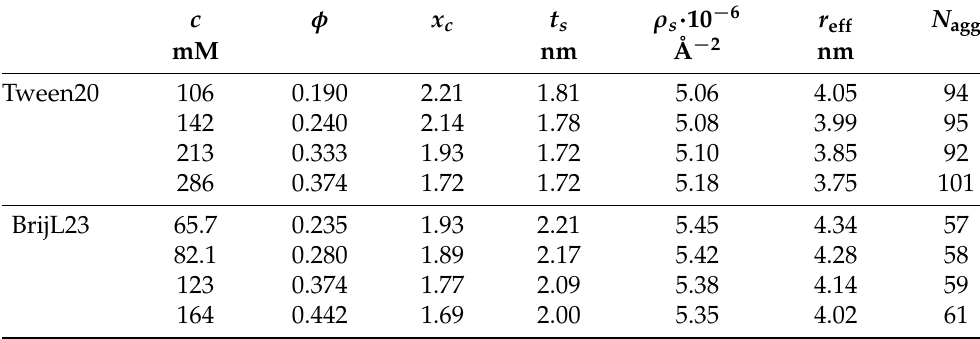
Table 1. Parameters extracted from SANS model fits (core-shell ellipsoid form factor + PY structure factor) of pure nonionic surfactants (Tween20 or BrijL23) in D 2 O at 20.0 ◦ C.